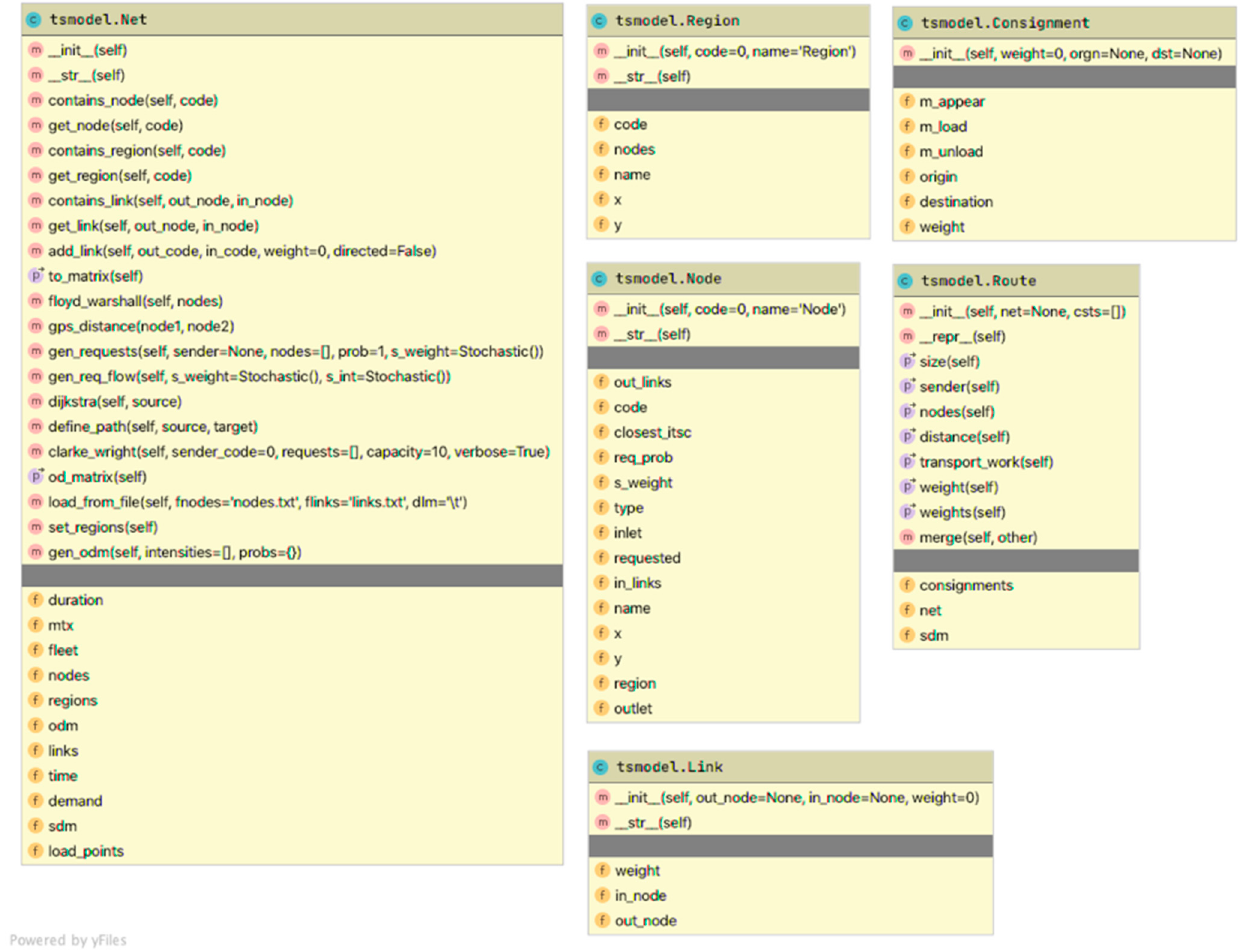
Figure 1. UML diagram of software implementation for the developed model.